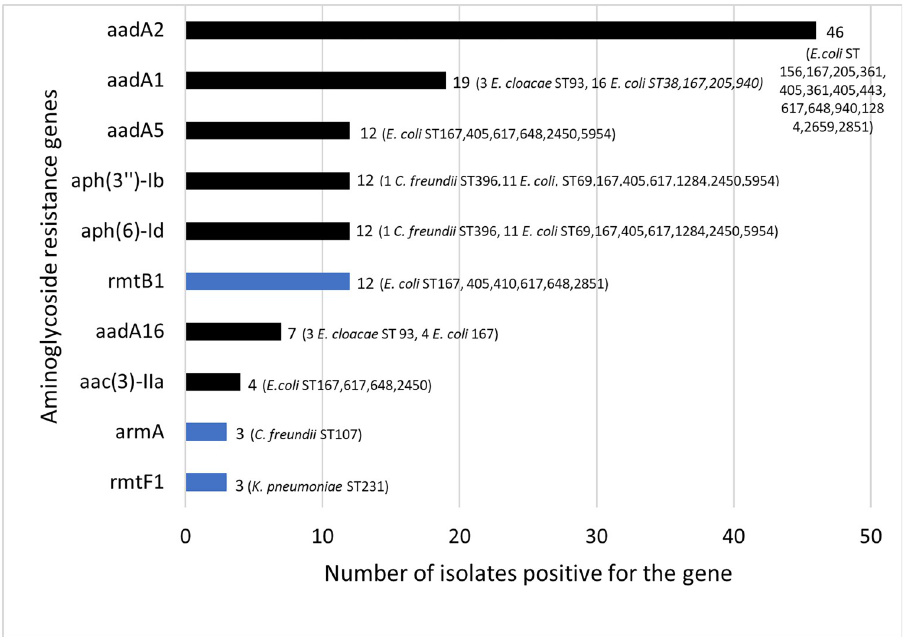
Fig 5. Bar plot depicting the distribution of aminoglycoside resistance–encoding